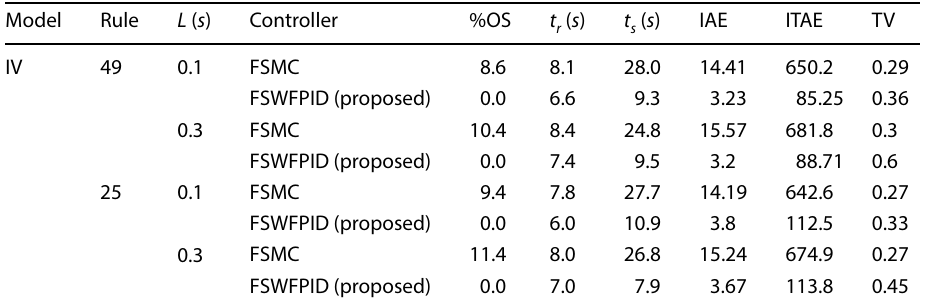
Table 14 Performance analysis for Model IV